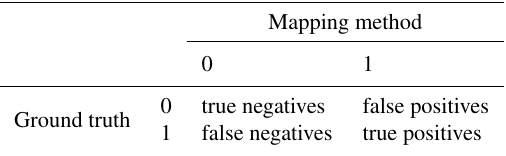
Table 3. Contingency table with two outcomes (avalanche is 1, no avalanche is 0; adapted from Trevethan,